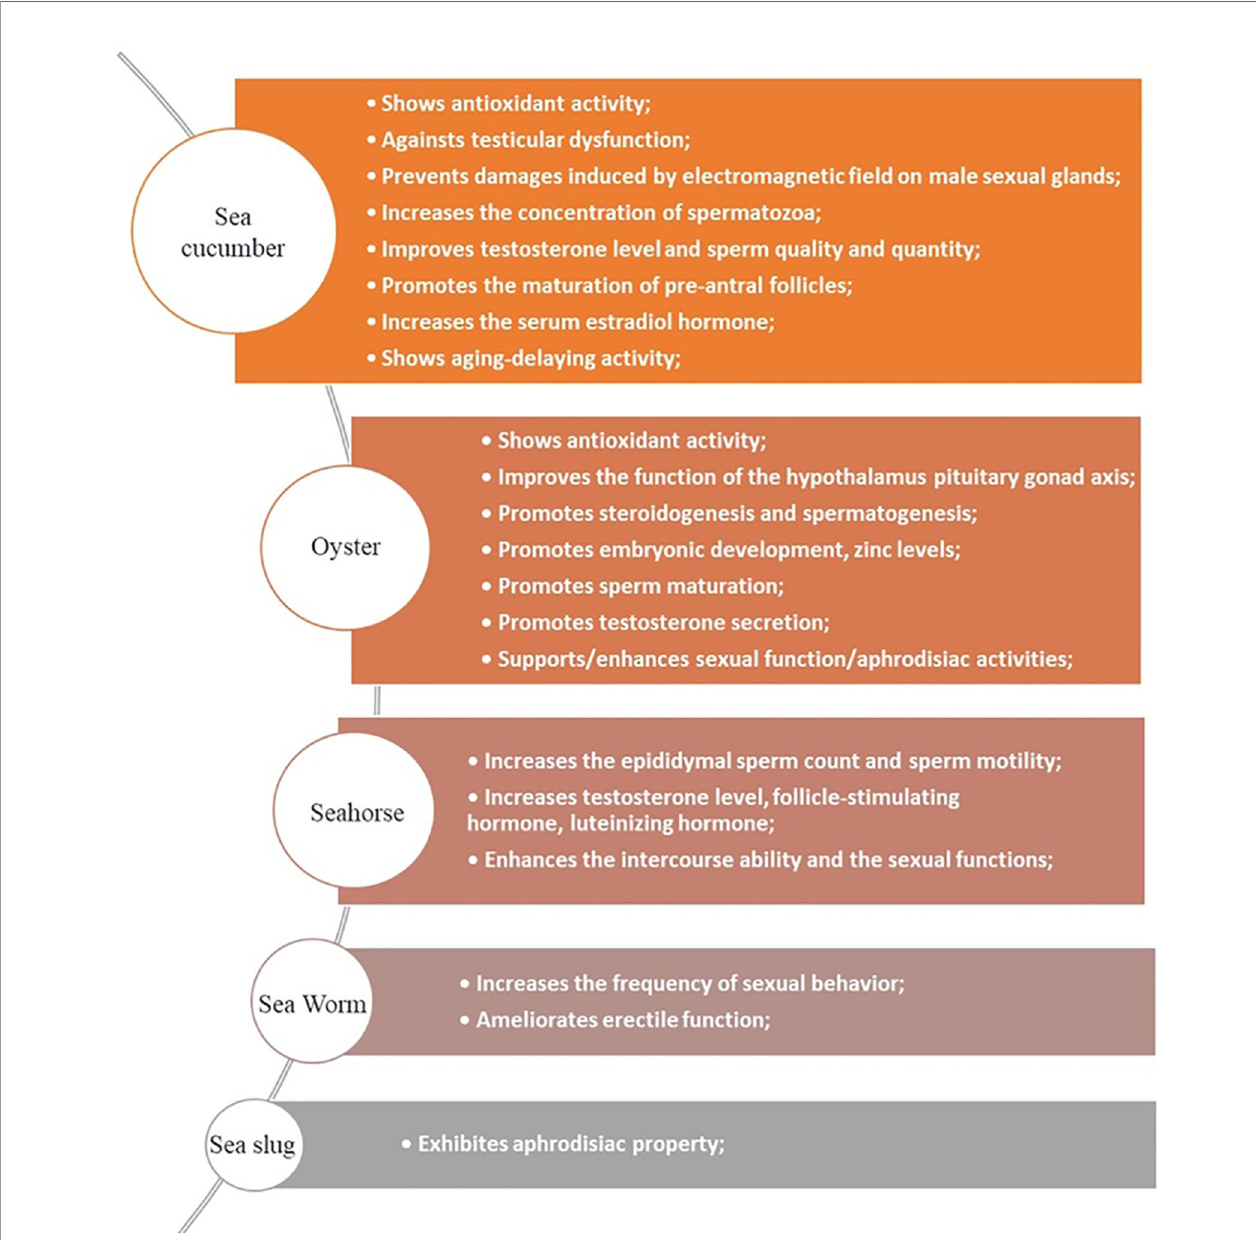
FIGURE 1 | A schematic summary of a range of marine animals reported with various functions to improve human reproductive health. These animals include sea cucumber, oyster, seahorse, sea worm and sea